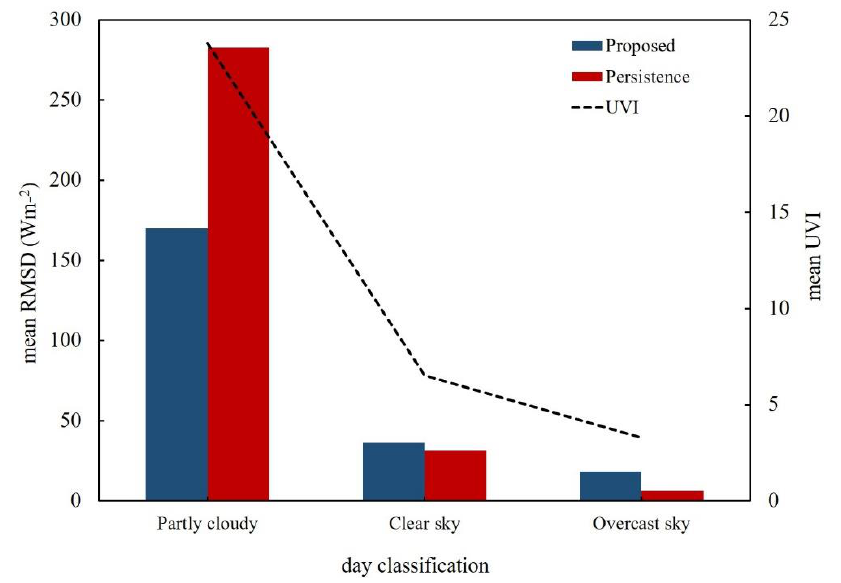
Figure 9. Comparison between proposed and persistence models using the mean values of RMSD and UVI for 10-min forecast horizon in partly cloudy, clear, and overcast days.